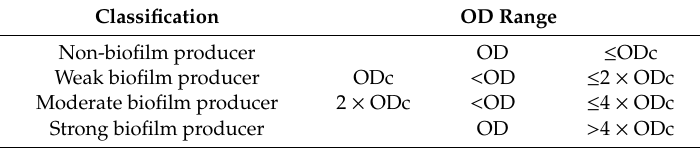
Table 1. Classification of biofilm-forming capacity based on optical density (OD)